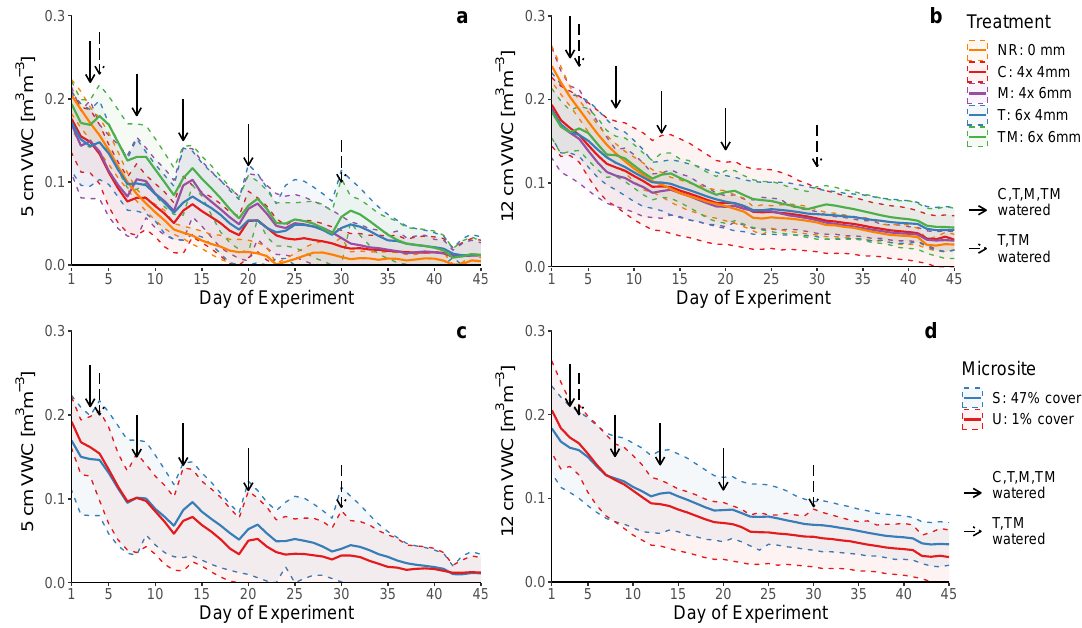
Figure 2. Timeseries of volumetric soil water content [VWC: m 3 m − 3 ] from Day 1 through Day 45 of the experiment (15 August 2020–30 September 2020) by treatment (NR: no rain, C: control (4 events; 4 mm per event), M: +50% magnitude (4 events; 6 mm per event), T: +50% timing (6 events; 4 mm per event), and TM: +50% timing and magnitude (6 events; 6 mm per event); Panels ( a , b )), microsite (shaded: S and unshaded: U; Panels ( c , d )), and soil depth (5 cm: panels ( a , c ); 12 cm: panels ( b , d )). Lines indicate daily mean VWC and shaded areas indicate the daily range of recorded VWC. Arrows indicate watering treatment days, with solid arrows indicating a day when groups C, M, T, and TM were watered and dashed arrows indicating days when only groups T and TM were